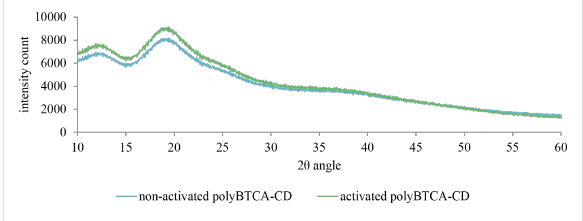
Figure 3: XRD pattern of the two polymers: non-activated and acti- vated